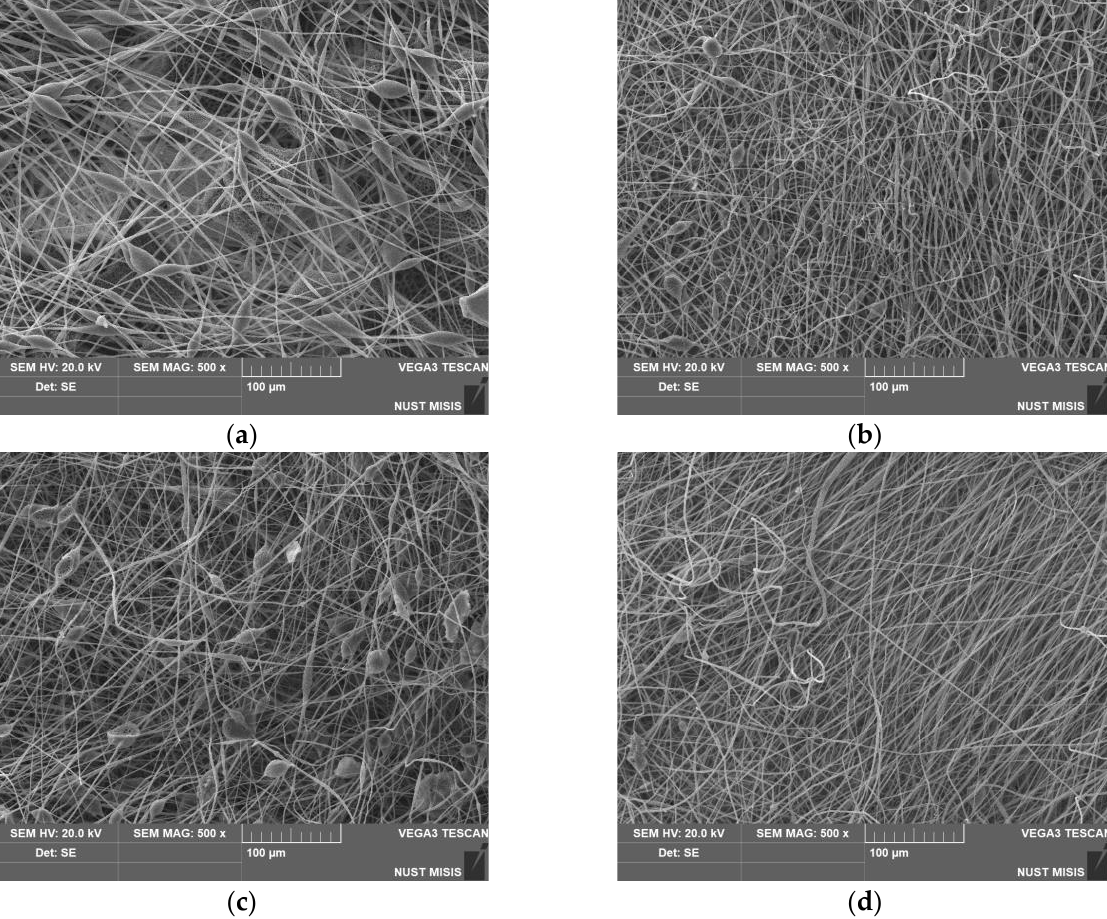
Figure 2. SEM images of electrospun materials based on PHB with different content of Hmi: 0% wt. ( a ), 1% wt. ( b ), 3% wt., ( c ) and 5% wt. ( d ). Table 3. Material properties of PHB–Hmi fibers a